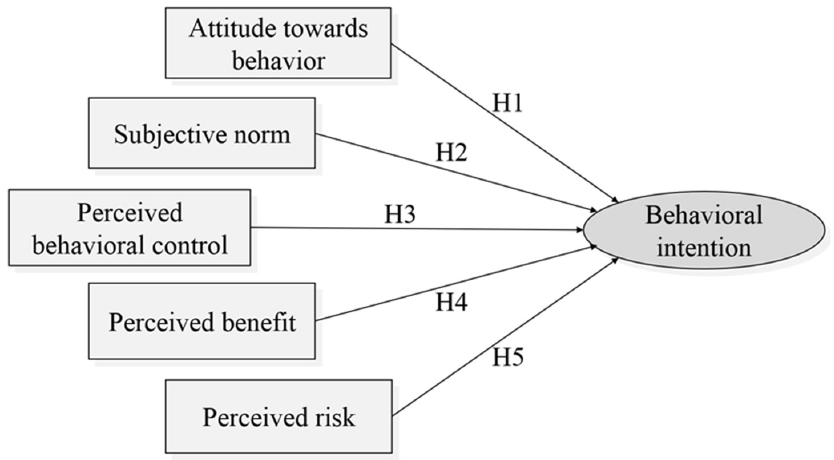
Figure 2. The preliminary theoretical